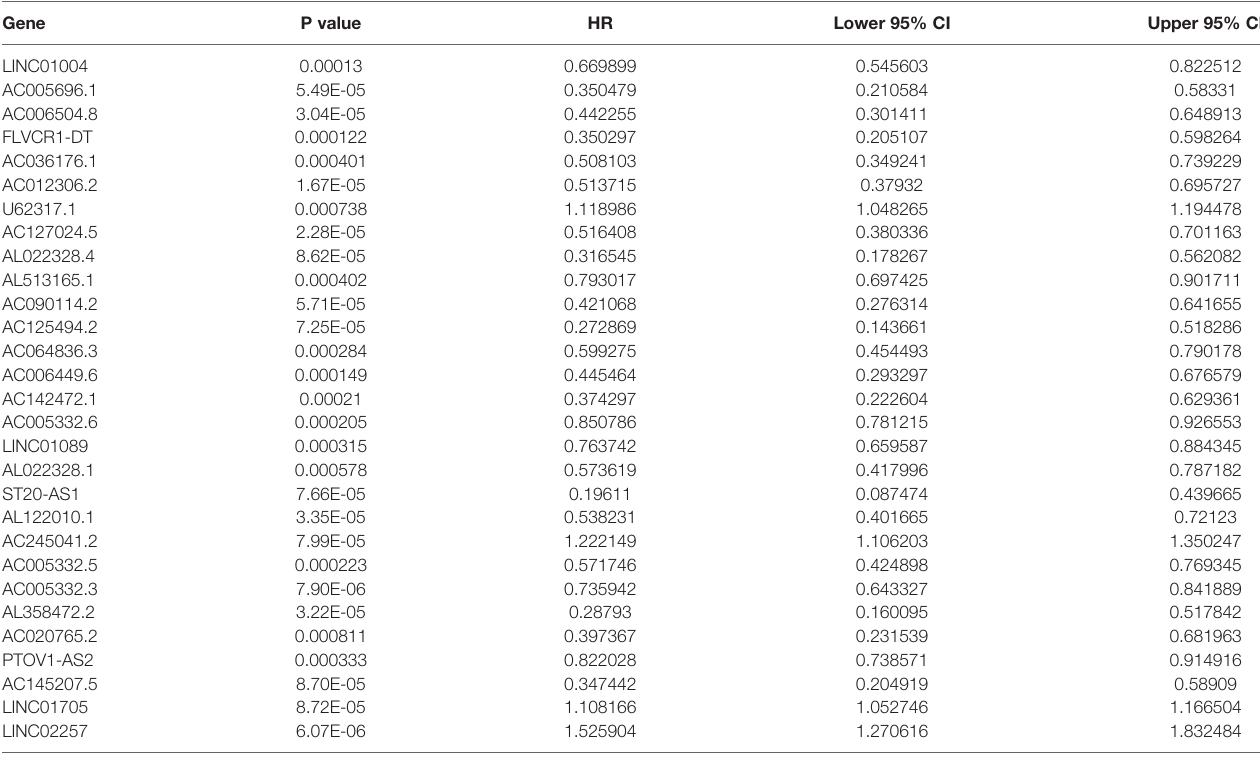
TABLE 1 | Univariate cox regression analysis of prognostic autophagy-associated lncRNAs. Gene P value